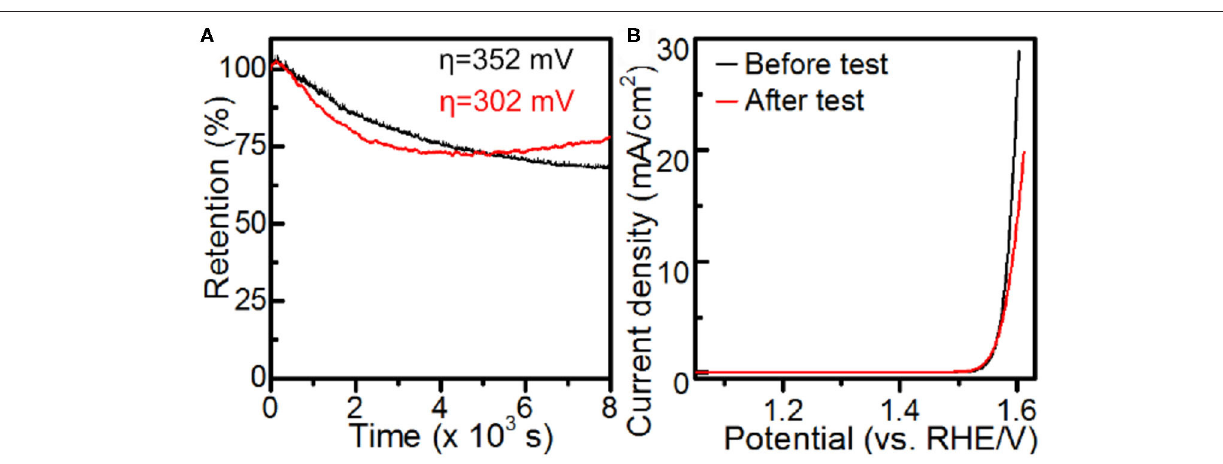
2016). Besides, a small shoulder peak at around 300 nm was observed together with continuous absorption of light in a broad wavelength range, which was more like a